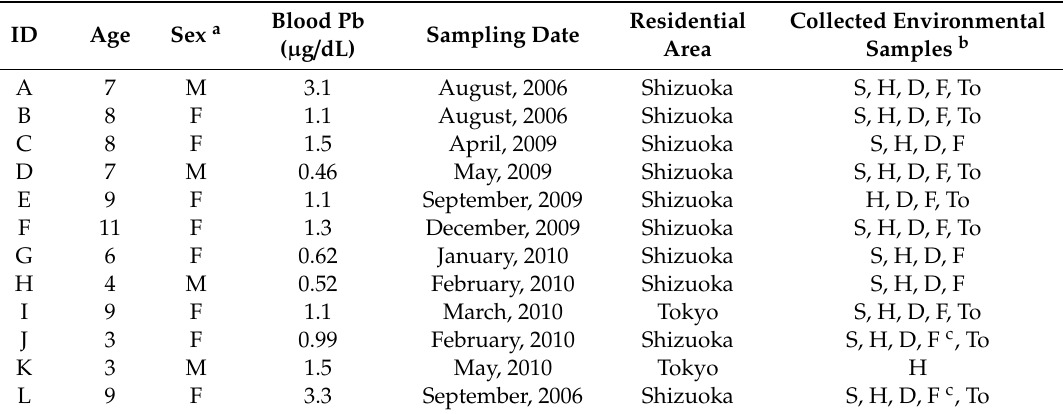
Table 1. Characteristics of study subjects (n =